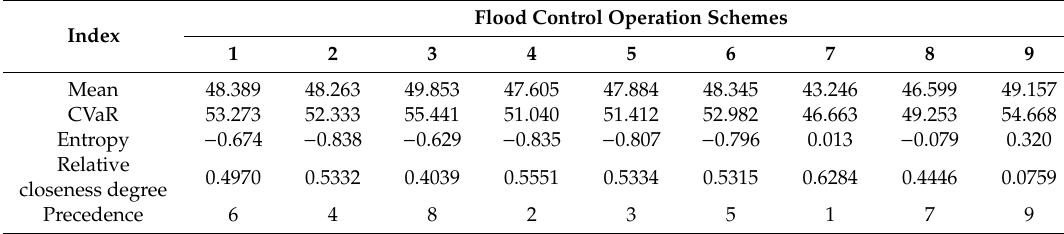
Table 7. Risk indexes and precedence of flood control operation scheme.